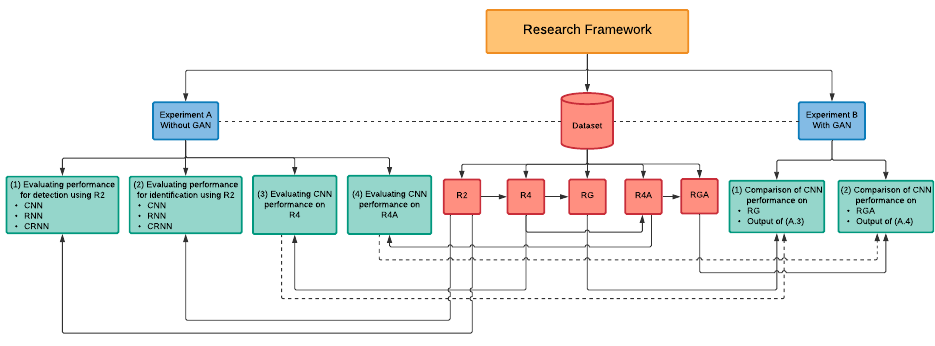
Figure 2. High level design of the proposed